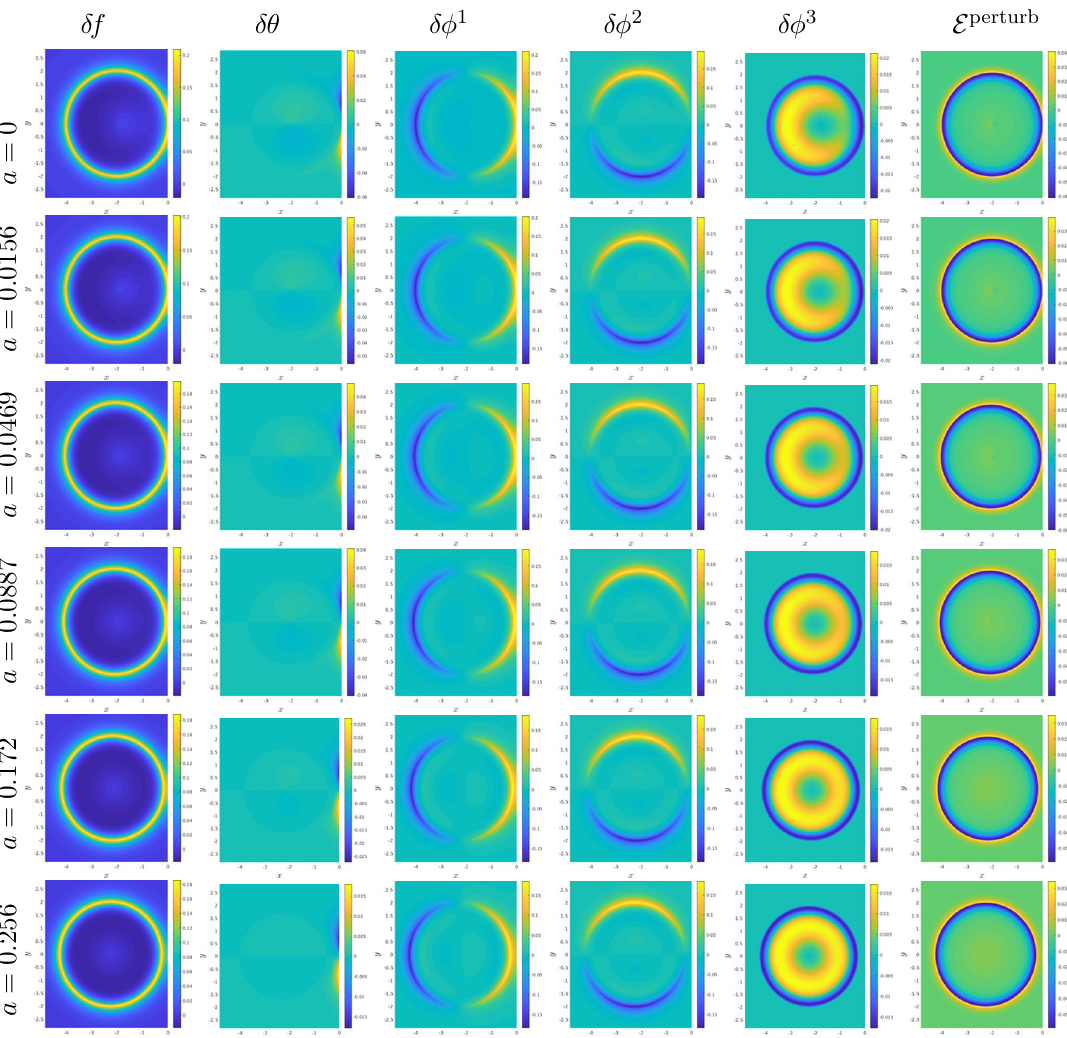
Figure 18 . Numerical solution for δf and δθ for two N = 1 compactons situated next two each other with separation distance 2 a for (cid:15) = 0 . 0428 . Due to symmetry of the problem, only the left- hand side is calculated and shown. The gluing conditions (5.9) are imposed at x = 0 , which is located at the right-most part of every panel. Each row displays the perturbations δf , δθ , δφ 1 , δφ 2 , δφ 3 and the energy density of the perturbation E perturb , each in its column. Each panel is cropped so as to render the content as clear as possible; the left, top and bottom border do not represent the size of the